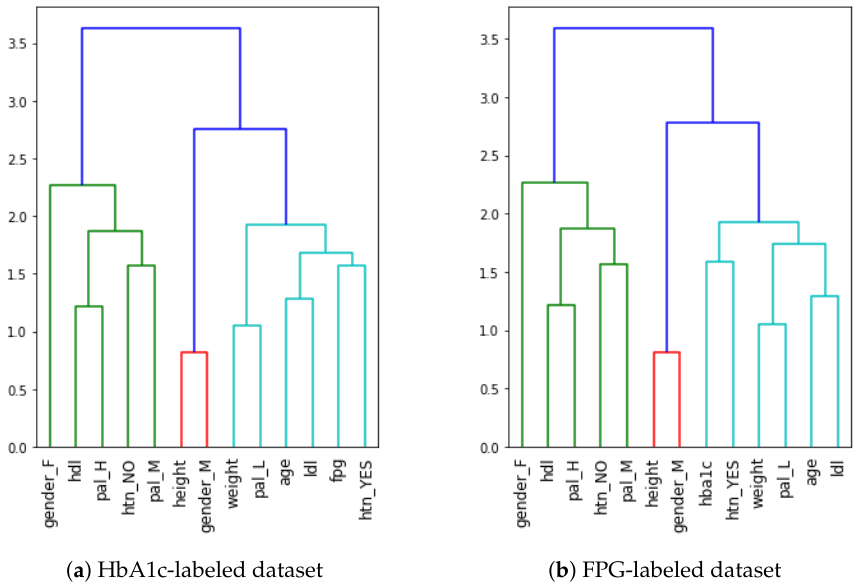
Figure 2. Dendrograms showing hierarchical clustering of the features in our datasets.